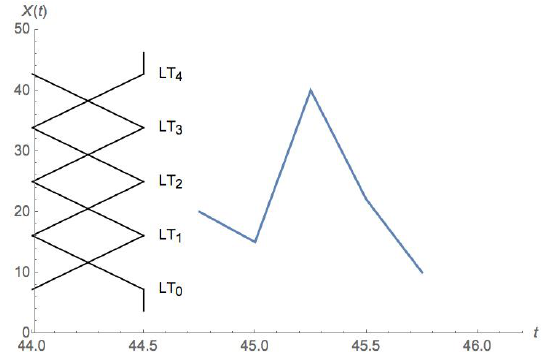
Figure 2. Part of a time series and corresponding fuzzy